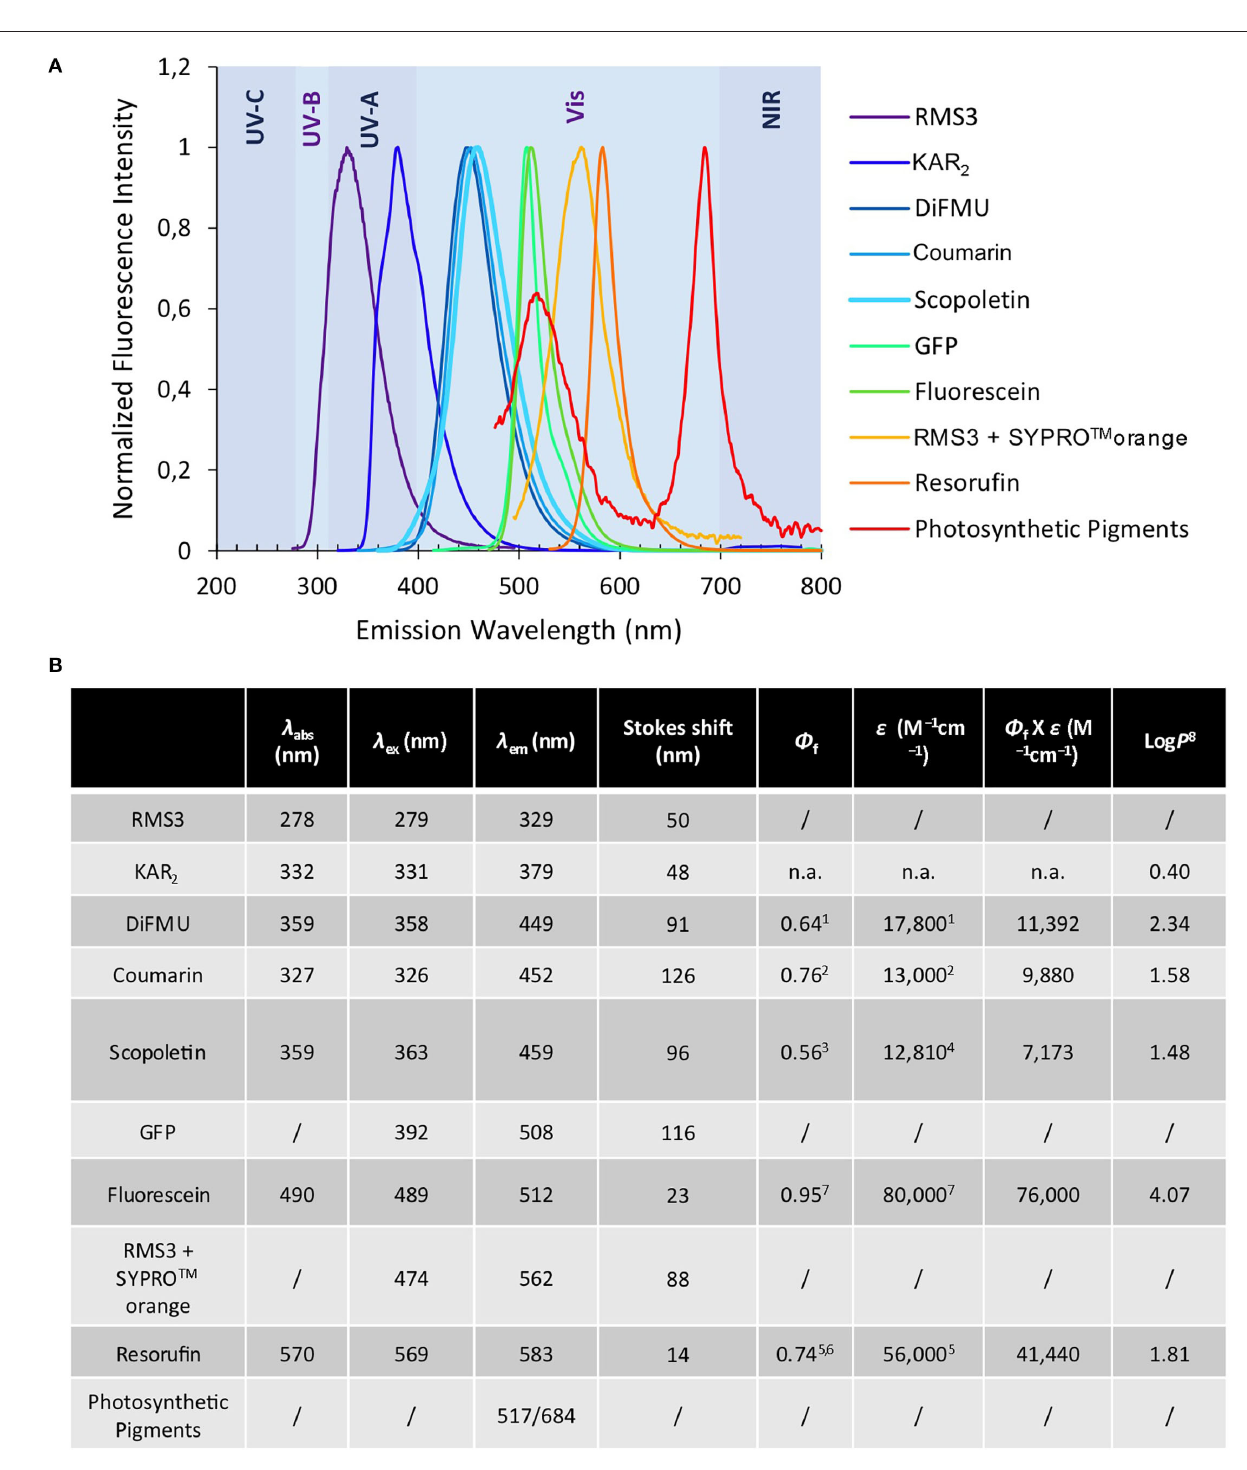
Frontiers in Plant Science |